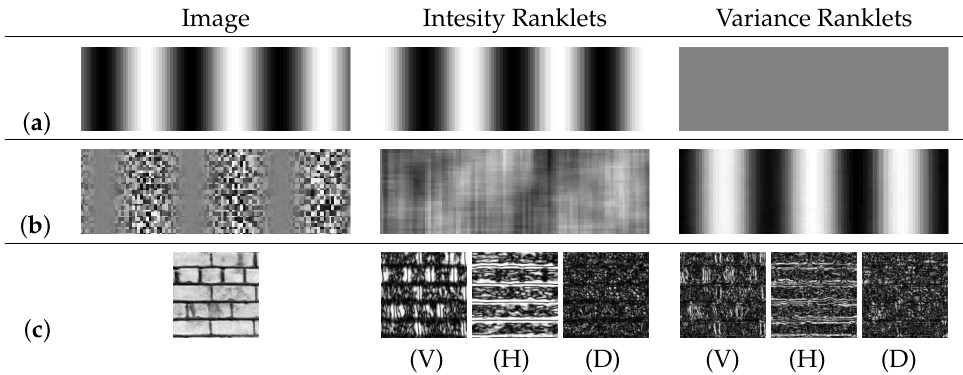
Figure 13. Intensity and Variance Ranklet responses to ( a ) an intensity modulation; ( b ) a variance modulation; ( c ) a texture image. For ( a , b ), vertical Ranklet responses are shown; for ( c ), we show the absolute value of Vertical, Horizontal and Diagonal filters. Image sources: texture D55, Brodatz